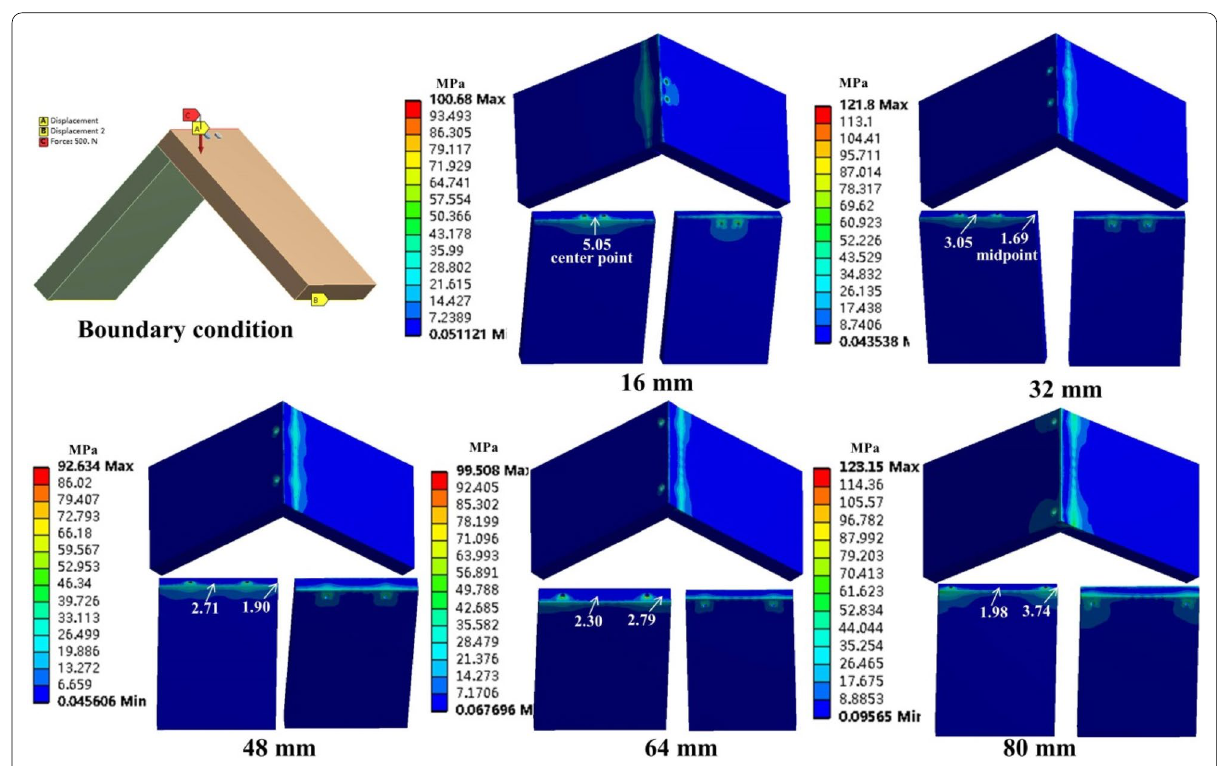
Fig. 11 Von Mises stresses of joints subjected to